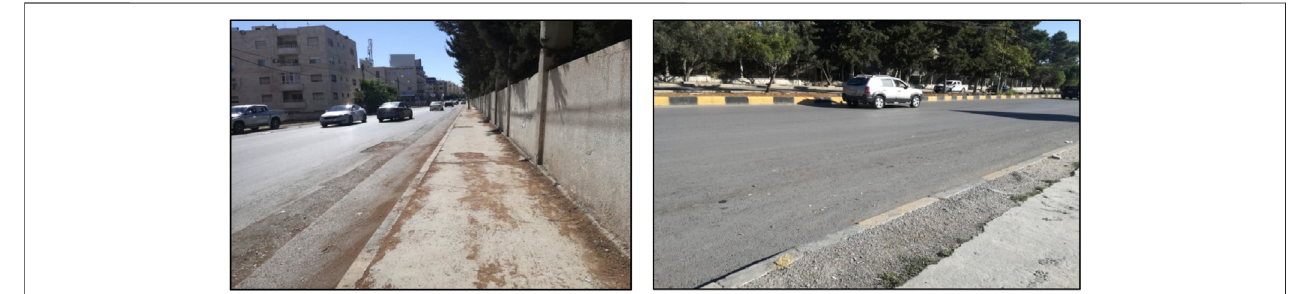
FIGURE 2 | Fawzi Almulki street (left) and Prince Hasan street (right).